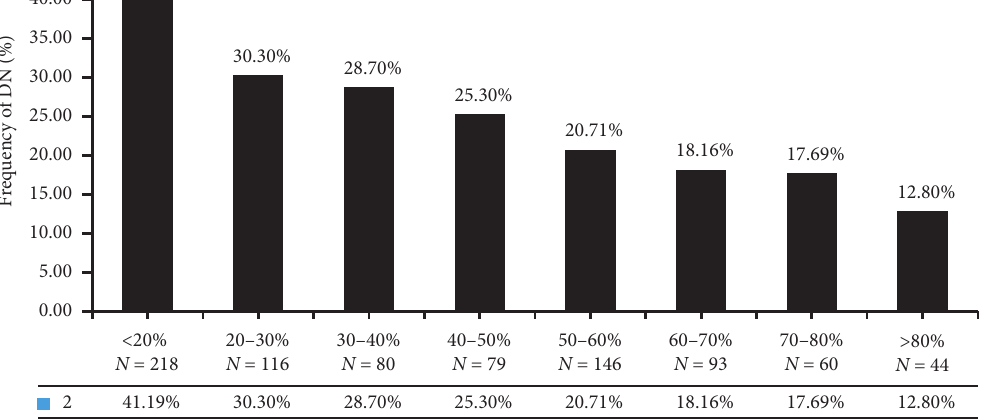
Figure 4: Distribution of DN with different TIR.